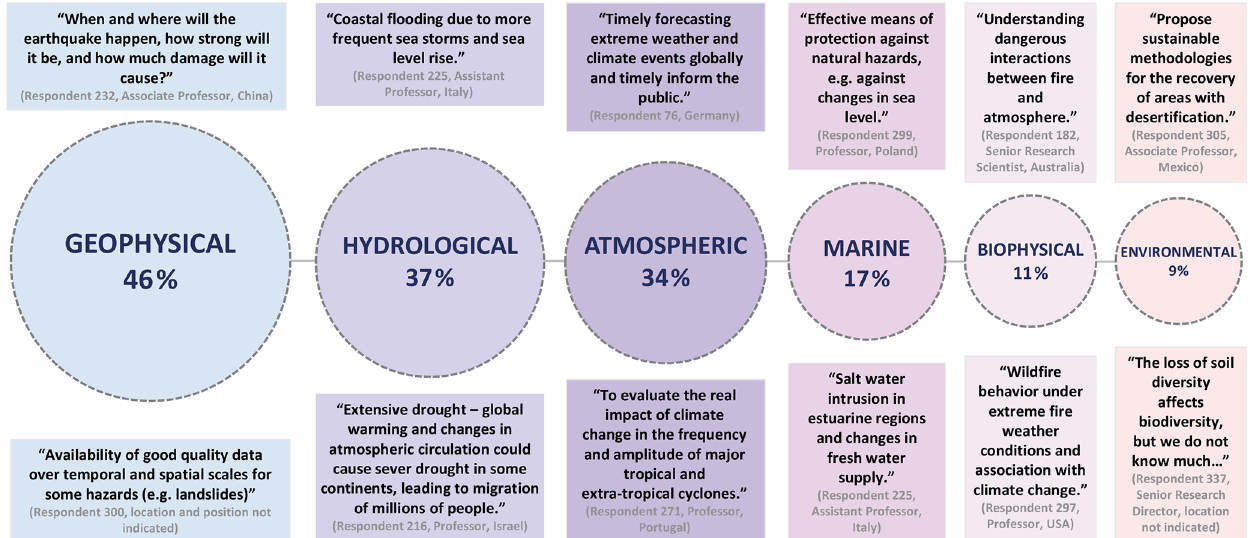
Figure 1. Major hazard groups identified by natural hazard community members to the NHESS survey question Q1 “what are the top three scientific challenges you believe are currently facing our understanding of natural hazards”, together with example quotes. The percentages given are with respect to the total number of respondents whose answers mentioned a specific hazard ( n = 123), not all respondents ( n =